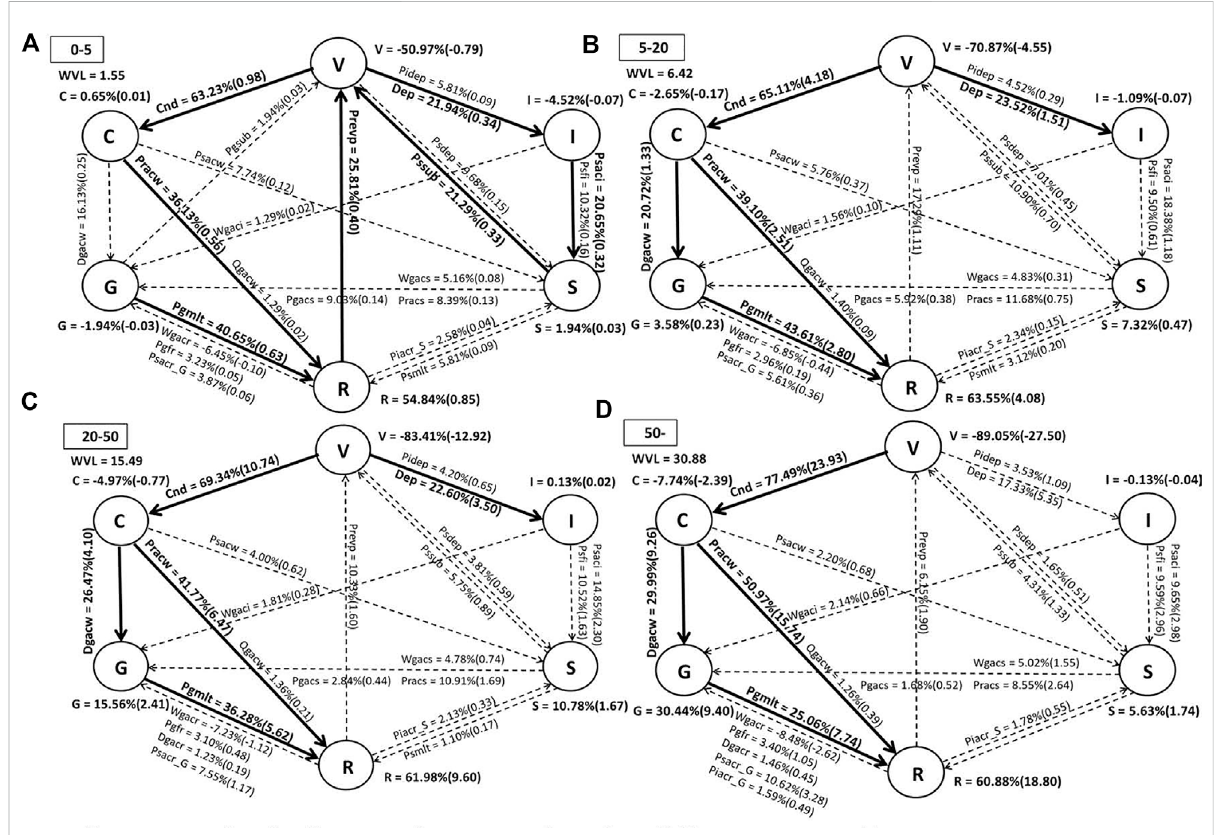
FIGURE 12 It is similar to Figure 11, but for different types (A) : 0-5 mm, (B) : 5-20 mm, (C) : 20-50 mm, and (D) : 50-